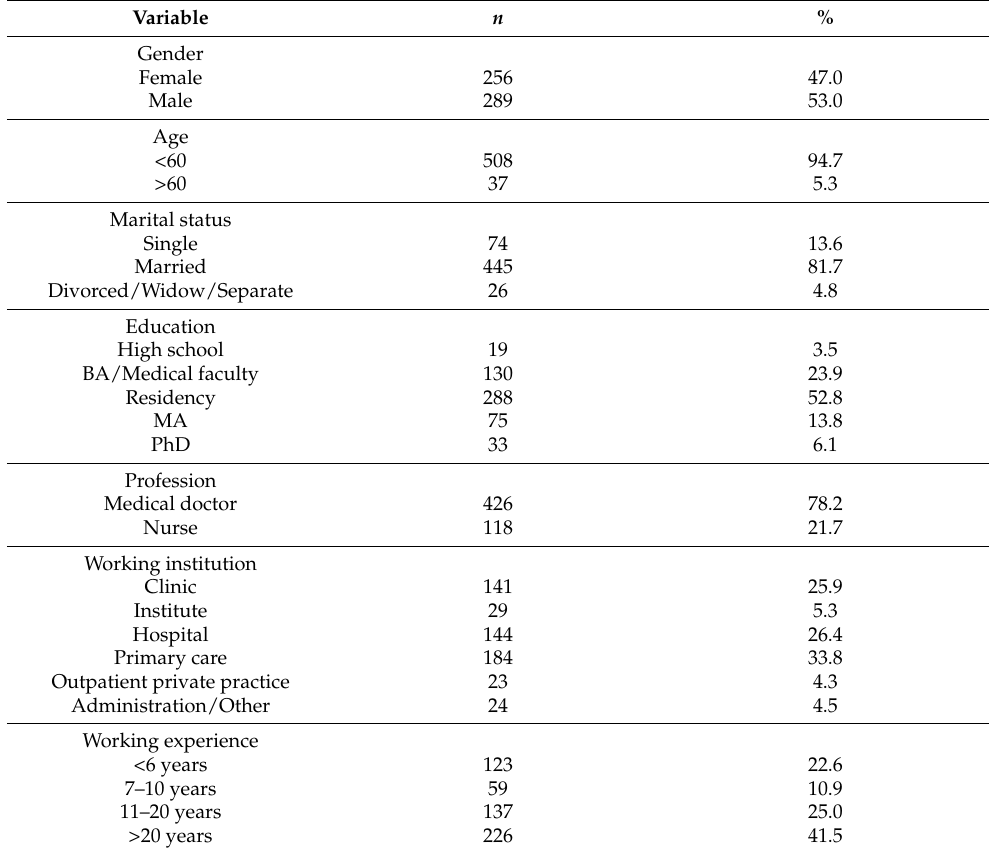
Table 1. Characteristics of study participants.